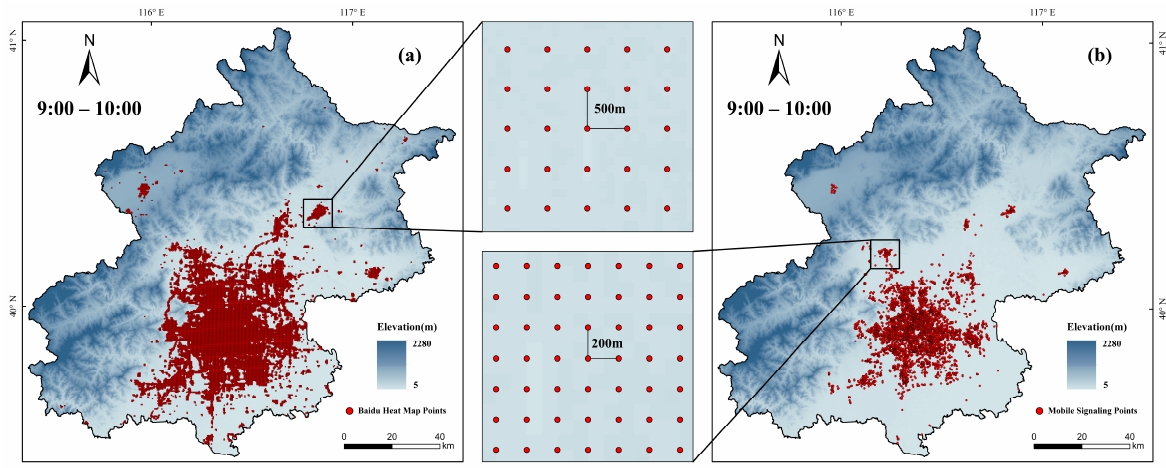
Figure 2. Vector point display of Baidu heat map data ( a ) and mobile signaling data ( b